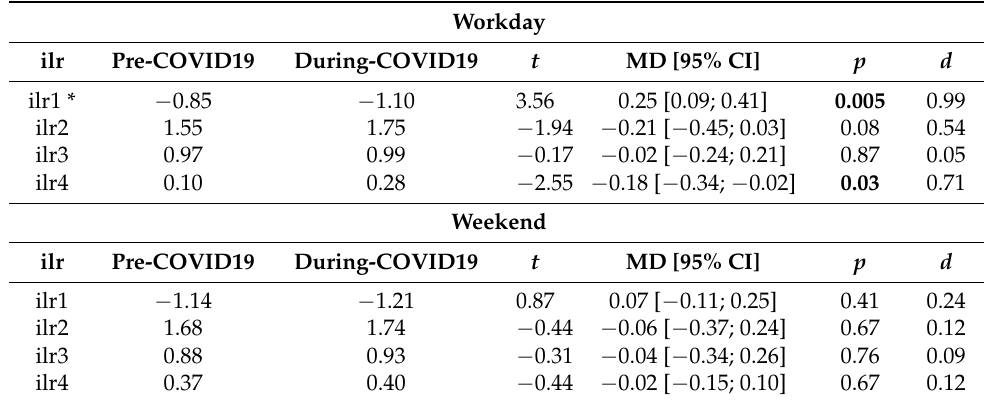
Table 3. Mean ilr coordinates pre-COVID19 and during-COVID19; results of the univariate post- hoc